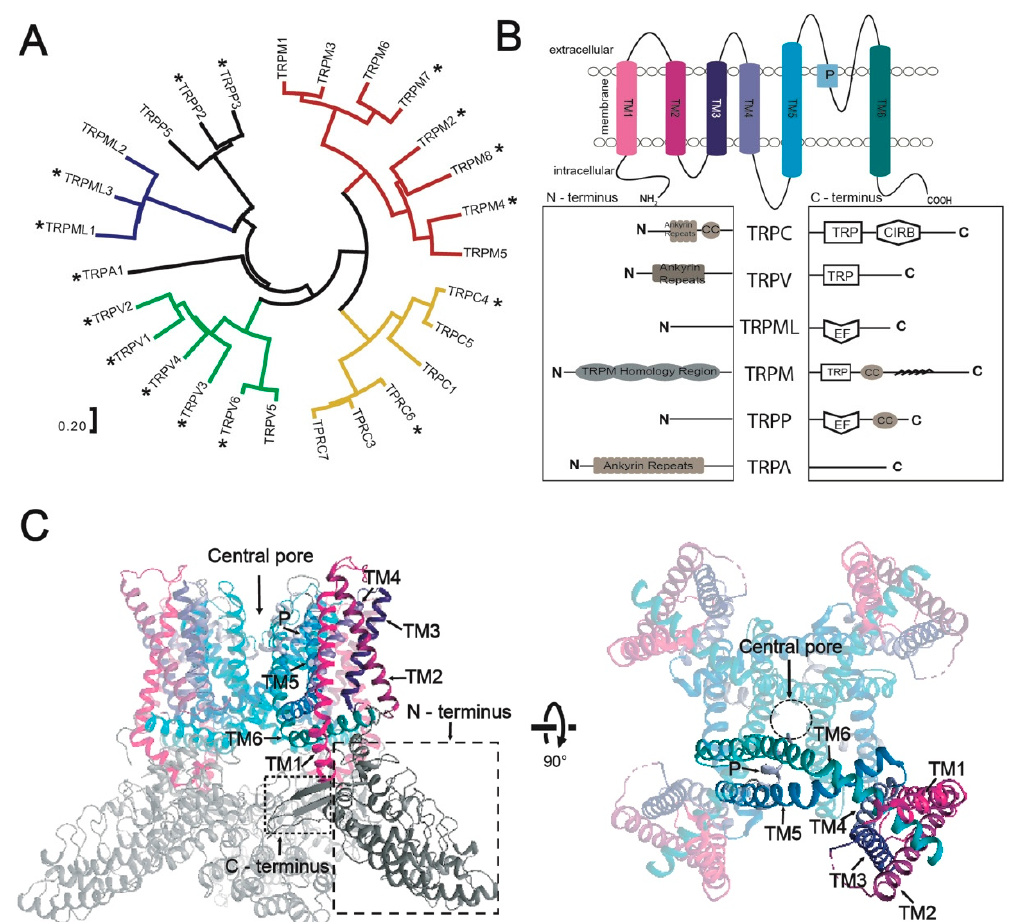
Figure 1. Human transient receptor potential (TRP) channels. ( A ) Phylogenetic distribution of the human TRP channel family including six subfamilies comprising proteins with distinct channel properties. Protein sequences were aligned using MEGA7 (https://www.megasoftware.net/). Structurally determined channels are highlighted with stars (not all structures were of protein with human origin, see also Table 1). ( B ) Topology of TRP channels showing in detail distinct architecture of the intracellular N- and C-termini across TRP channel subfamilies. ( C ) Overall structure of TRP channels with three out of the four monomers shown in pale colors (the structure of TRPV1, PDB-ID: 3J5P [14], was used as a model). TRP channel monomers consist of six transmembrane helices (TM1 to TM6) that assemble as tetramers with a single ion conducting central pore in the center formed by TM5, TM6 and the interconnecting pore-loop